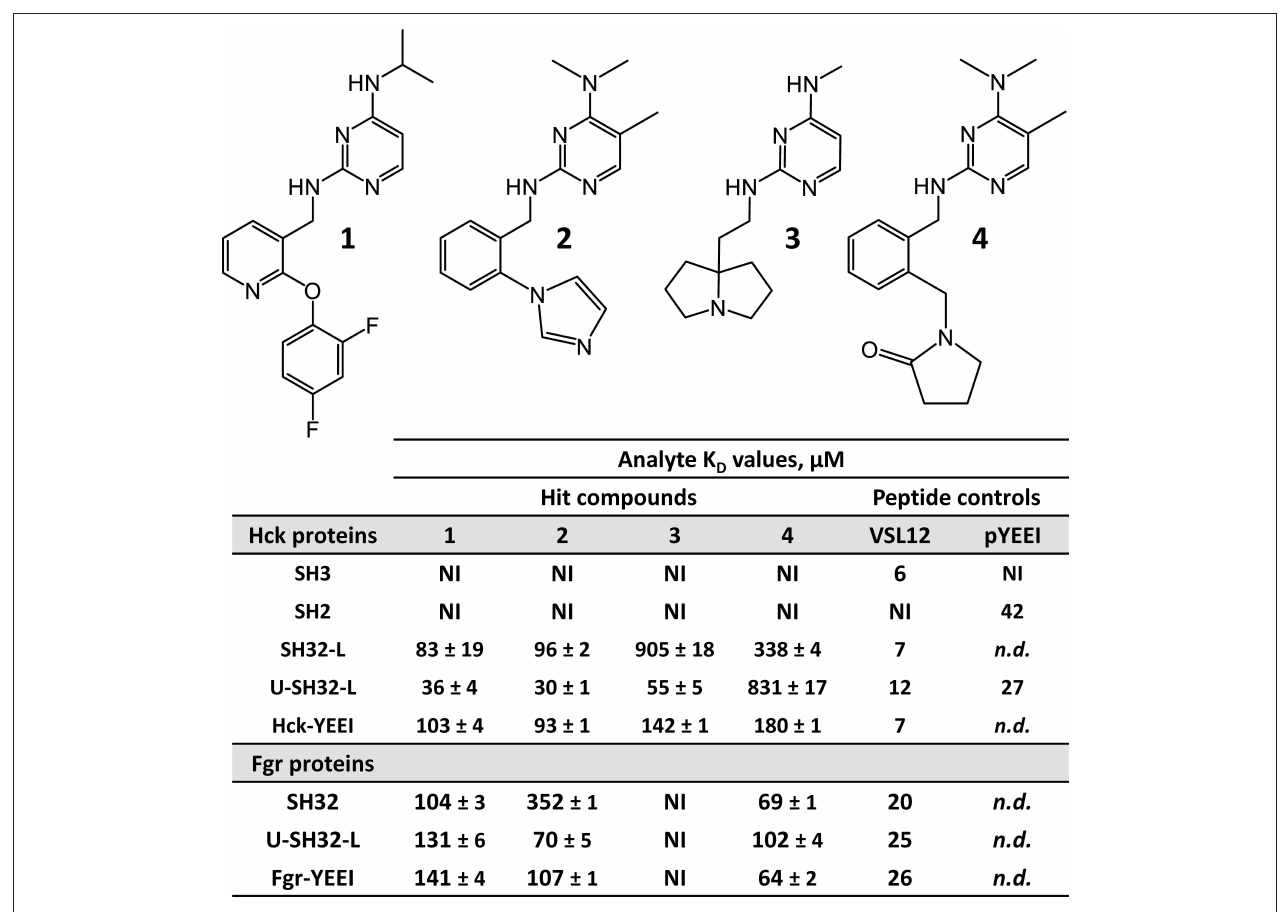
FIGURE 4 | FP-based HTS of the ChemBridge 50K compound diversity set with the Hck-U32L protein identifies four hit compounds with a shared pyrimidine diamine substructure. The structures of the four hit compounds are shown at the top. Each compound was tested for direct interaction with each of the Hck and Fgr proteins listed using SPR as described in the legend to Figure 5 . SPR data were best fit by a 1:1 Langmuir model yielding the kinetic K D values shown ± S.E. No binding was observed with the isolated Hck SH3 or SH2 domains. Peptides that selectively interact with the SH3 domain (VSL12) or the SH2 domain (pYEEI) were included as positive controls. NI, no interaction; n.d. , not